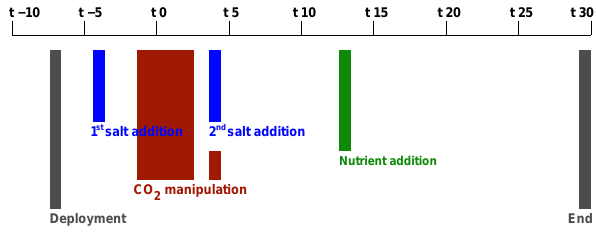
Fig. 1. Timeline of major experimental manipulations. Mesocosm deployment was on 31 May, day t –7. The experiment ended on 7 July on day t 30. See Sect. 2 for